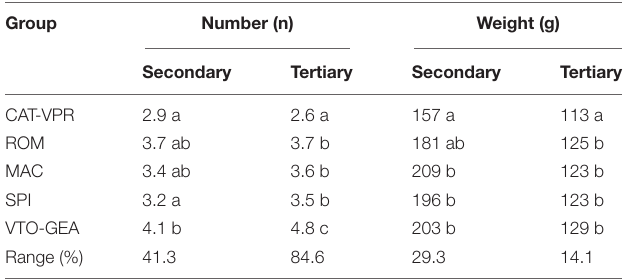
TABLE 5 | Average numbers and weights of the secondary and tertiary heads for the five SSR-derived groups of cultivated globe artichokes. Group Number (n)